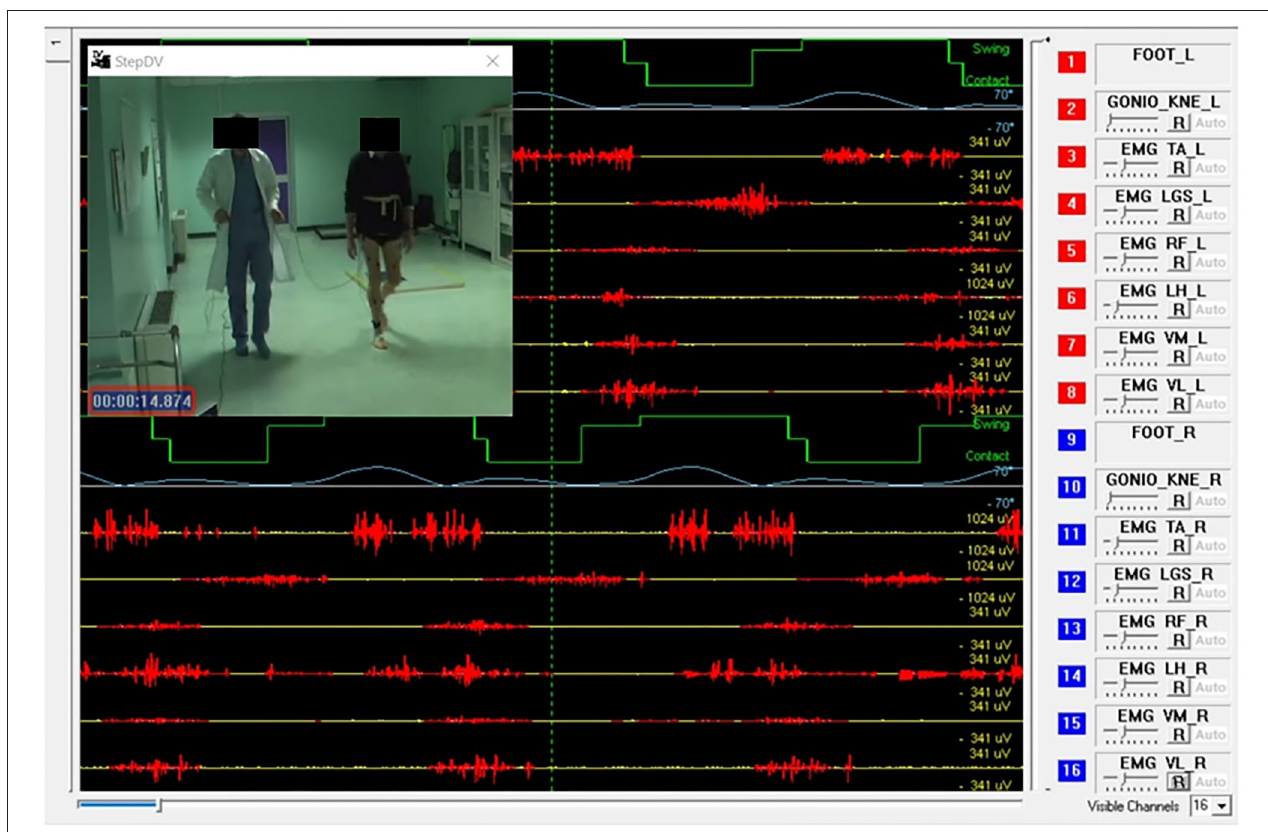
FIGURE 2 | Example of signals acquired during a gait analysis session (multichannel recording system: STEP32, Medical Technology, Italy). Sixteen channels are synchronized with a video recording of gait: 8 for the left side (channels from 1 to 8) and 8 for the right side (channels from 9 to 16). For each lower limb the screenshot shows: 1 foot-switch-signal (green), 1 knee joint-angle kinematic signal in the sagittal plane (light blue), 5 sEMG signals over Tibialis Anterior (TA), Lateral Gastrocnemius (LGS), Rectus Femoris (RF), Lateral Hamstrings (LH), and Vastus Lateralis (VL). For each muscle, the activation patterns are automatically recognized by the system, and displayed in red, while the background noise is